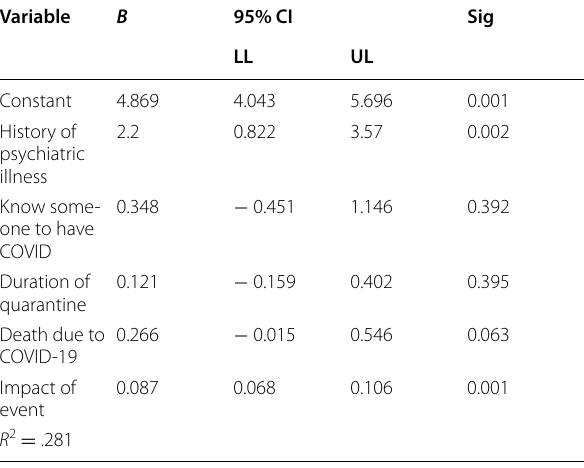
Table 2 Predictors of anxiety among respondents after the first wave of COVID‑19